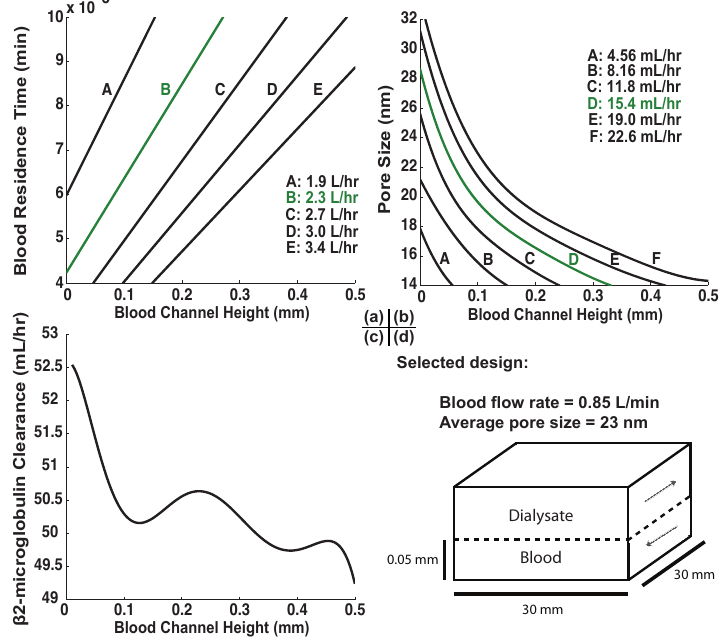
Figure 5. Dialyzer optimization process. Volume per time values in plots ( a – c ) are products of the volumetric flow rate of blood and the fractional clearance of urea, albumin, and β 2 -microglobulin, respectively. Curves shown are polynomial fits used to express all values as a function of channel height only. ( a ) Isolines of urea clearance with changing blood channel height and blood residence time; line B (green) is the isoline where urea clearance is at the desired value; ( b ) Isocurves of albumin clearance with changing channel height and pore size, with residence time calculated as a function of channel height in order to maintain constant urea clearance. Curve D (green) is the desired curve in this plot; ( c ) β 2 -microglobulin clearance as a function of channel height with constant urea and albumin clearances. The shape of this relationship is complex owing to the simultaneous change of three separate variables represented by changes in blood channel height (channel height itself, in addition to blood residence time and pore size); ( d ) Final proof-of-principle design selection. While a channel height of 0.05 millimeters does not correspond to the global maximum of β 2 -microglobulin clearance, it is a good compromise between clearance and